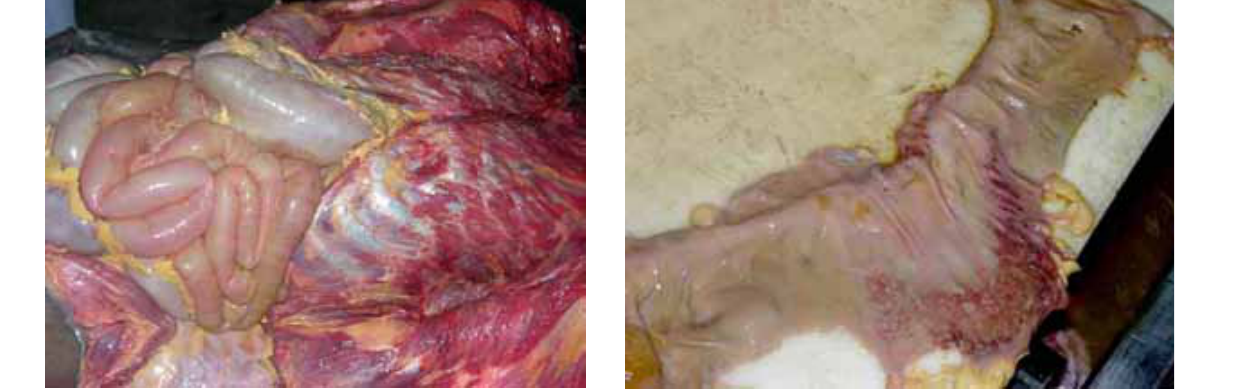
Fig. 1 Grossly distended intestine on opening the abdomen Fig 2 Area of patchy haemorrhage in the